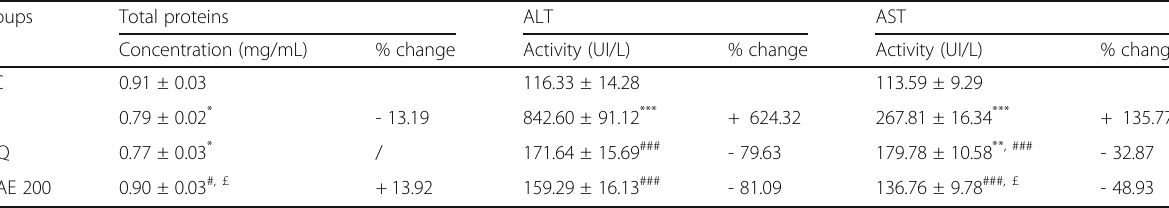
Table 2 Effect of oral treatment of Sida pilosa aqueous extract on plasma total proteins and transaminases activities of Schistosoma mansoni -infected mice